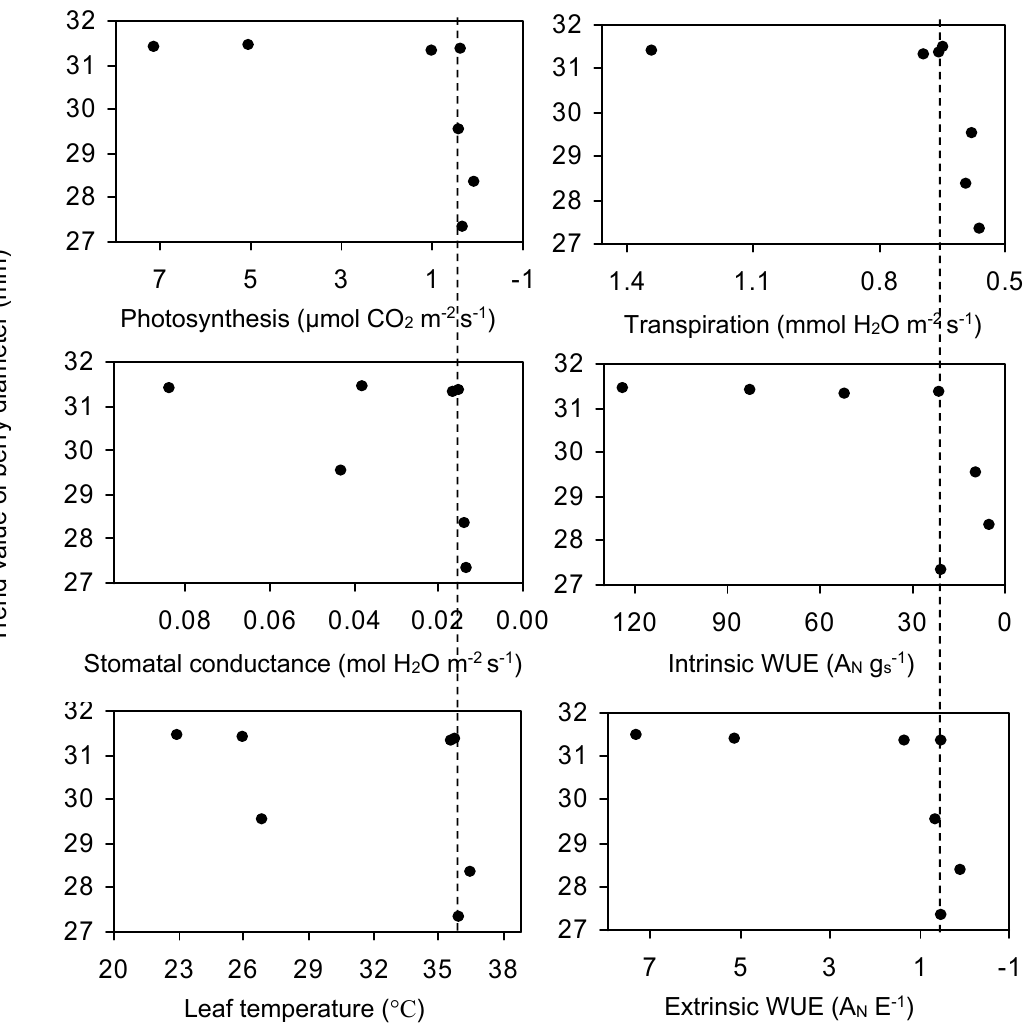
Figure 6. Relationship between trend value of berry diameter and leaf photosynthesis (A N ), stomatal conductance (g s ), transpiration (E), leaf temperature, intrinsic WUE (A N g s − 1 as µmol CO 2 mol H 2 O − 1 ) and extrinsic WUE (A N E − 1 as mmol CO 2 mol H 2 O − 1 ) of primary leaves of the grapevine in the morning in Stage III. Values are means and error bars represent SE ( n = 3).